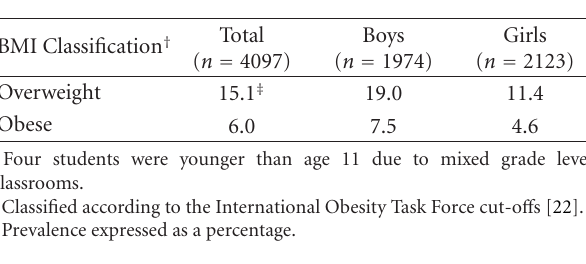
Table 1: Percentage of overweight and obesity, by gender, among adolescents aged 11 to 17 years ∗